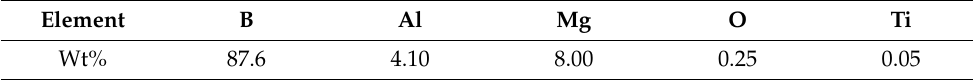
Table 4. Results of the elemental analysis of a typical microsection on the fracture surface. Element